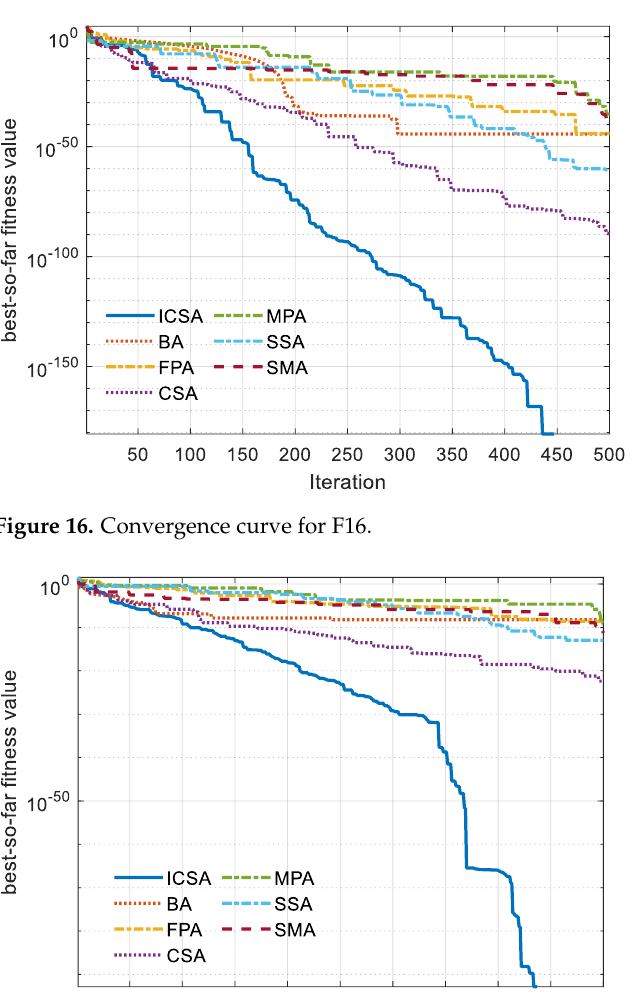
Figure 15. Convergence curve for F15.